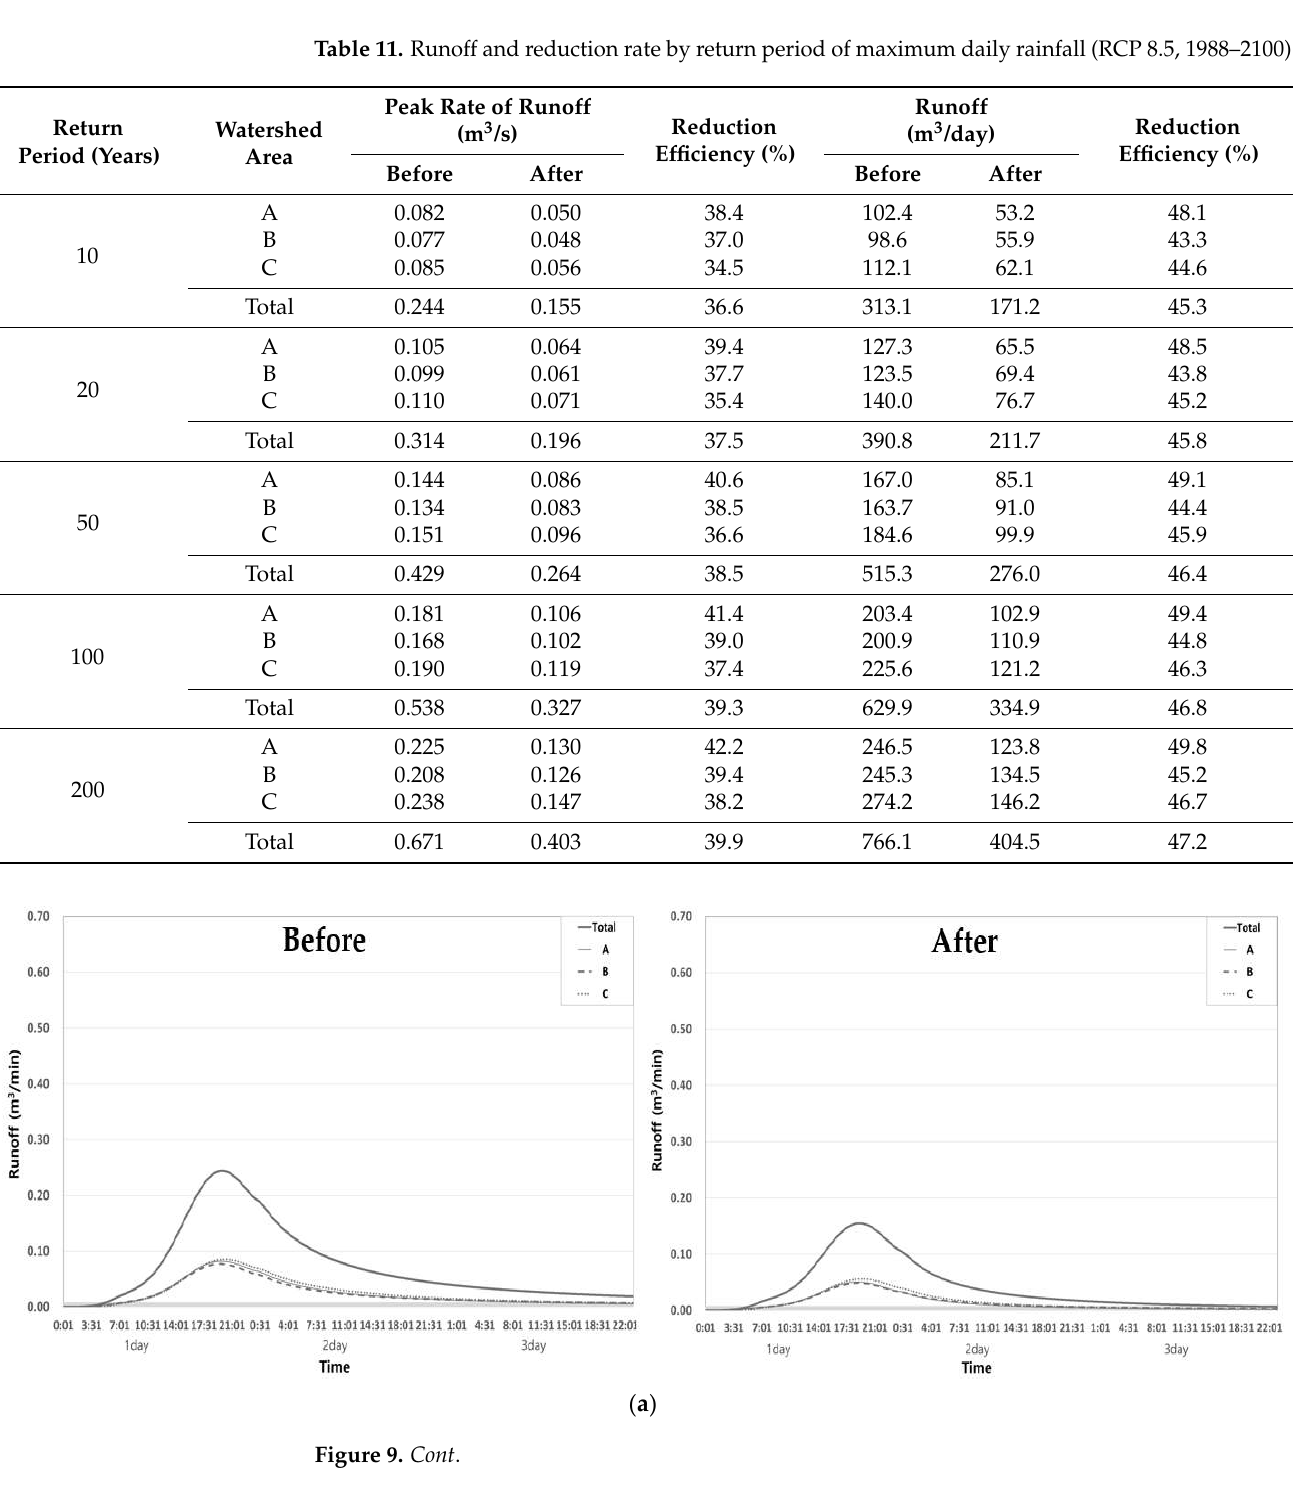
Table 11. Runoff and reduction rate by return period of maximum daily rainfall (RCP 8.5, 1988–